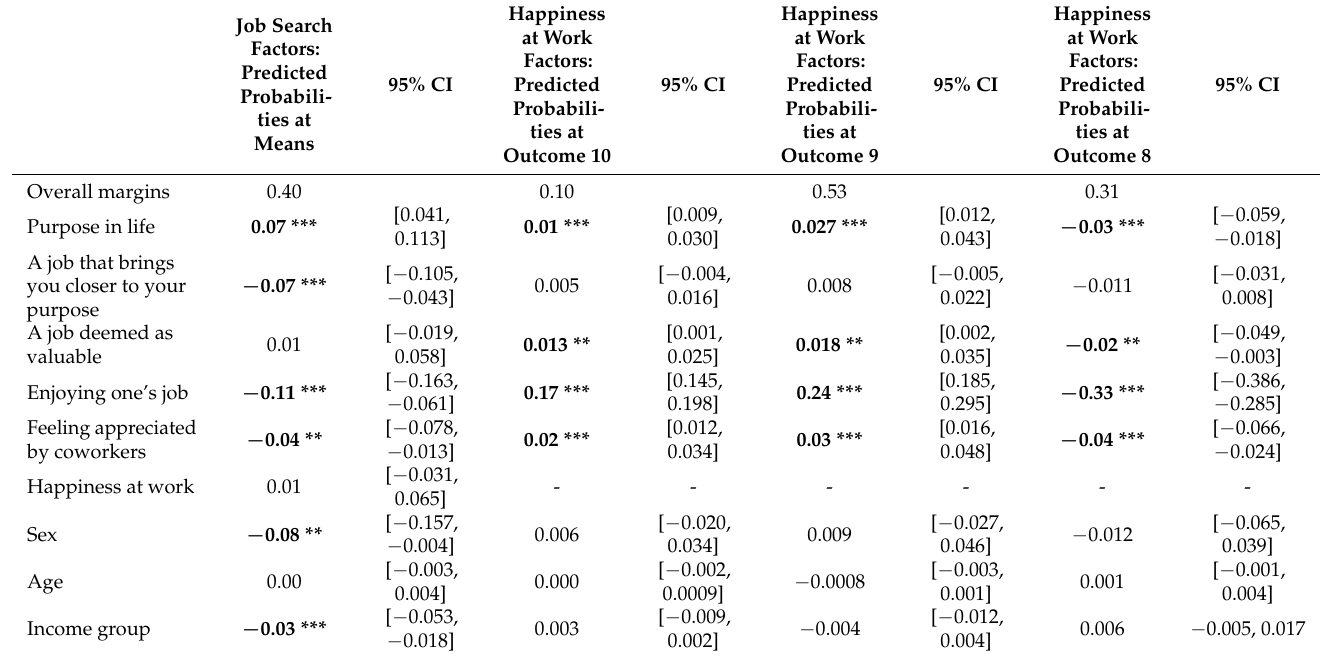
Table 2. Marginal analyses: Predicted probabilities of Turnover Intention and Happiness at Work at factor outcomes 8, 9, and